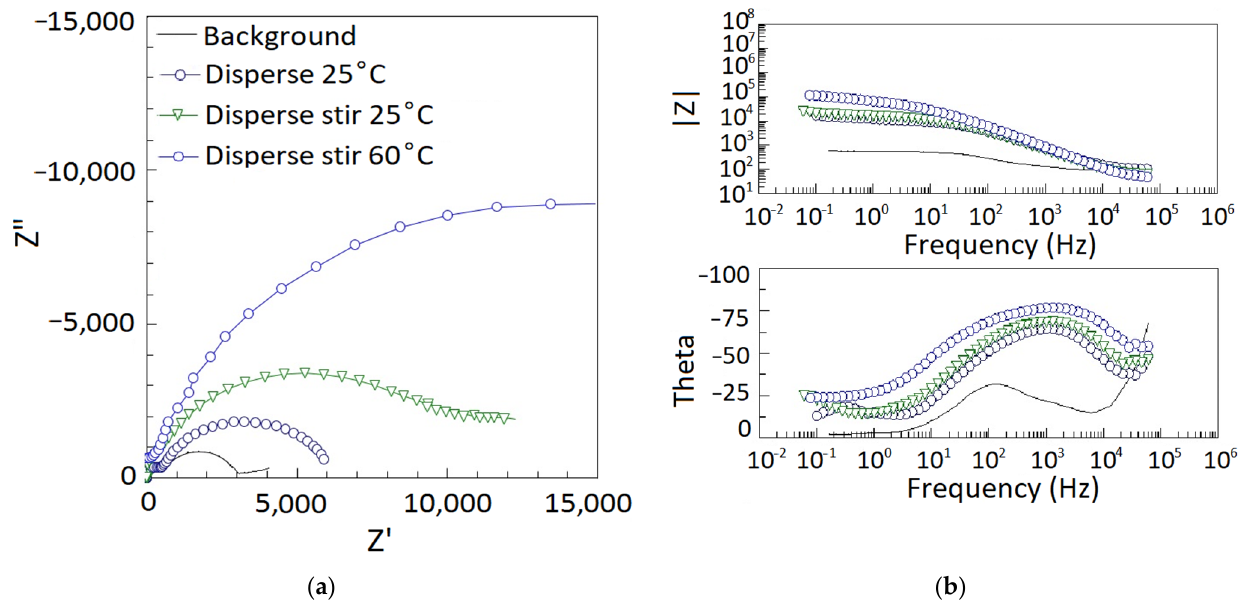
Figure 3. Plots for steel samples after exposure in an ID of an inhibitor composition with and without stirring of the solution for 60 min: ( a ) Nyquist; ( b ) Bode.